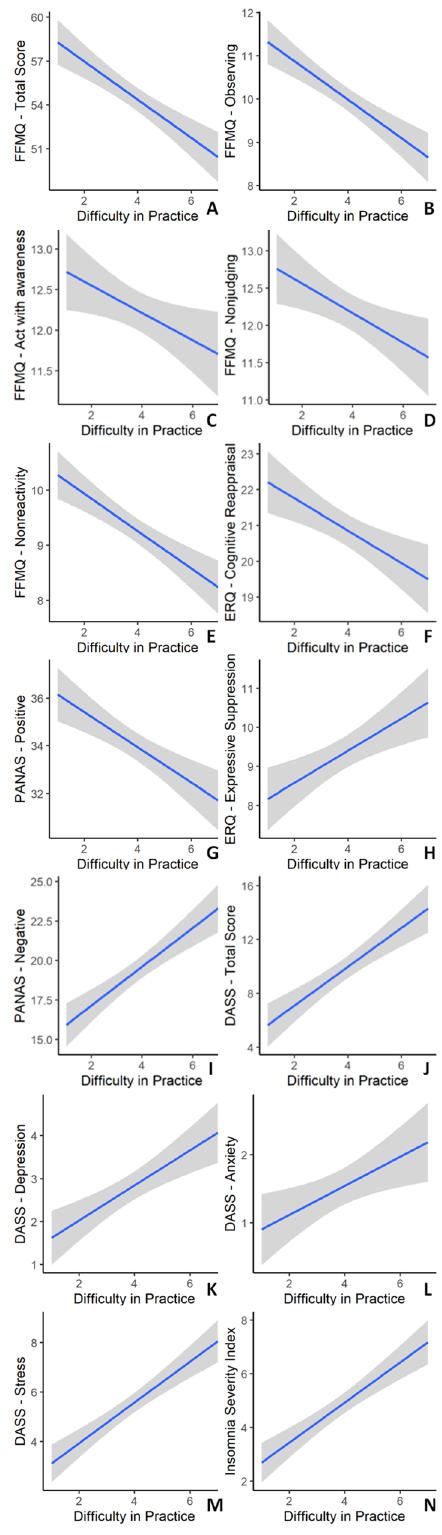
Figure 3. Plots showing significant correlations between the difficulty perceived in weekly mindfulness practice and several variables in the intervention group. The x-axis represents difficulty perceived in weekly practice (ranging from 1—very easy to 7—very difficult) and the y-axes represent ( A ) mindfulness total score (FFMQ-15), ( B ) observing subscale (FFMQ-15), ( C ) acting with awareness subscale (FFMQ-15), ( D ) nonjudging subscale (FFMQ-15), ( E ) nonreactivity subscale (FFMQ-15), ( F ) cognitive reappraisal subscale (ERQ), ( G ) positive affect (PANAS), ( H ) expressive suppression subscale (ERQ), ( I ) negative affect (PANAS), ( J ) DASS-21 total score, ( K ) depression subscale (DASS-21), ( L ) anxiety subscale (DASS-21), ( M ) stress subscale (DASS-21), ( N ) insomnia (ISI). The grey shaded area represents 95% confidence